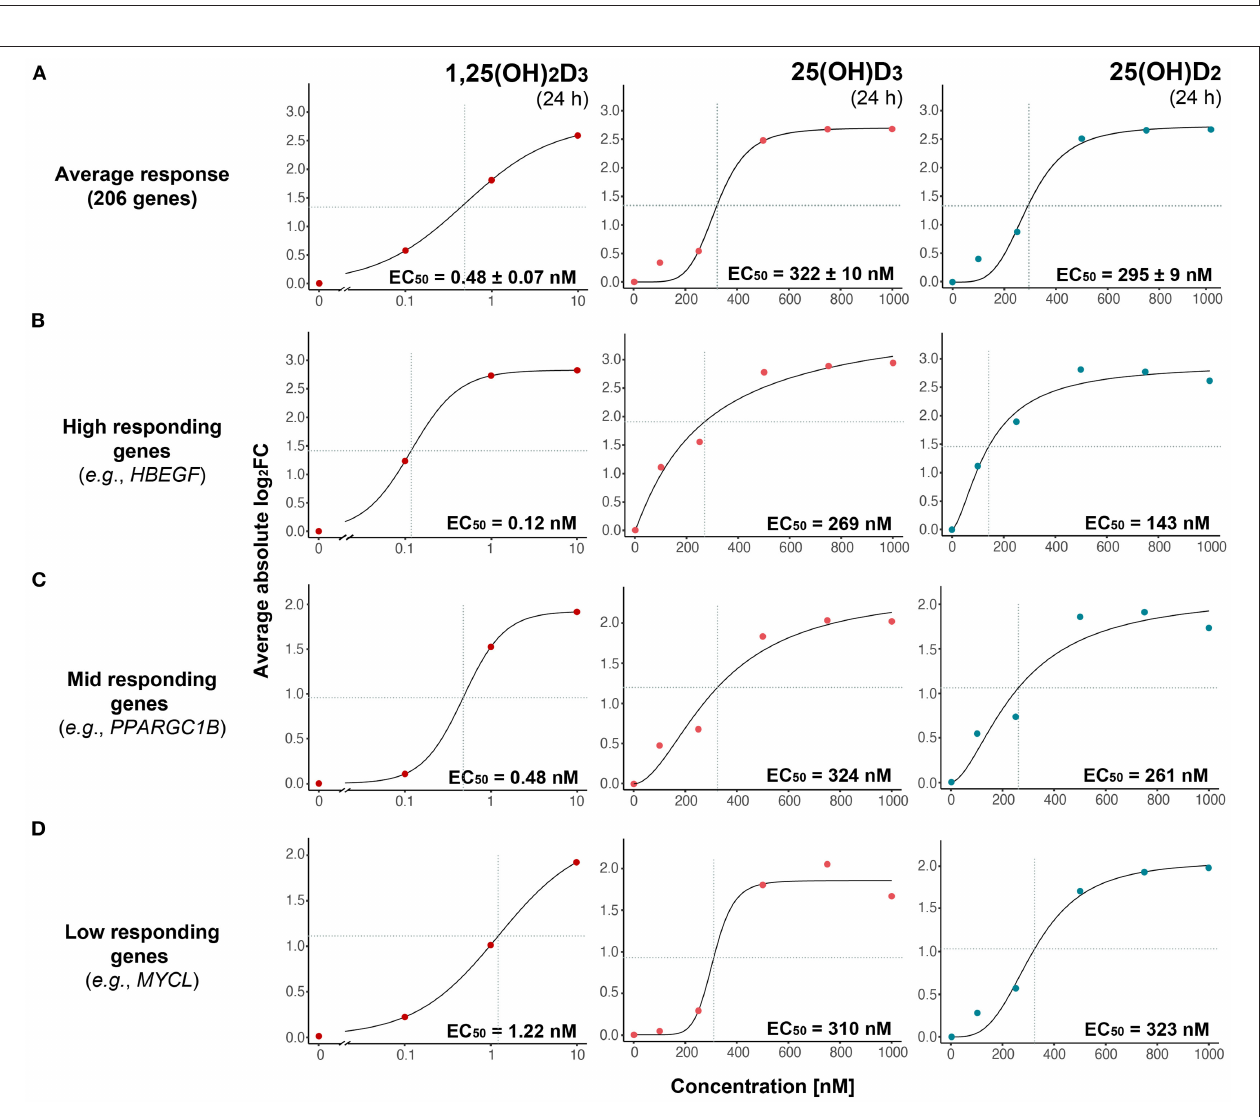
FIGURE 1 | treated and control samples is shown in relation to its mean expression level (log 2 CPM). Differential expression analysis was performed as a pairwise comparison per each concentration by using glmTreat test. Significantly (FDR < 0.05) up- and down-regulated genes are highlighted in red and blue, respectively. Horizonal lines (red) indicate the applied statistical testing threshold (absolute FC > 2). The top 5 responsive genes (up- and down-regulated) are labeled. Venn diagrams show the overlap of vitamin D target genes per metabolite (B) . The relations between all treatments and concentrations (at 24 h) are provided in Supplementary Figure 3 . Box and violin plots summarize the distribution of the magnitude of expression change (absolute log 2 FC) of the 206 common genes for each vitamin D metabolite and concentration (C) . Solid lines within the boxes indicate medians, while dashed lines mark the mean.